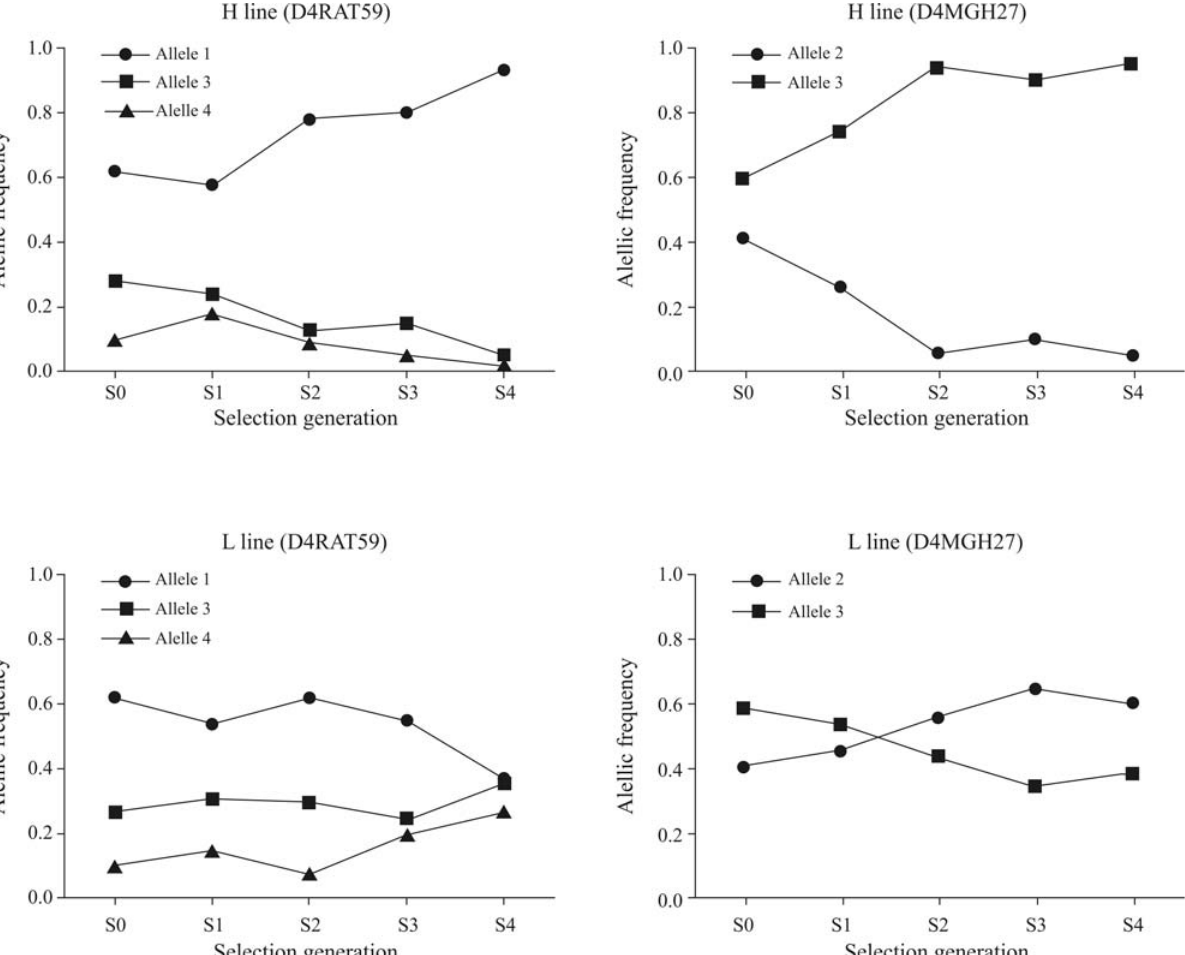
Figure 1 - Frequencies of alleles 1, 3 and 4 of the microsatellite marker D4RAT59 (left panels), and of alleles 2 and 3 of the microsatellite marker D4MGH27 (right panels), both located on rat chromosome 4, from generation S0 to S4 of selective breeding in the Floripa H (top) and L (bottom) rat